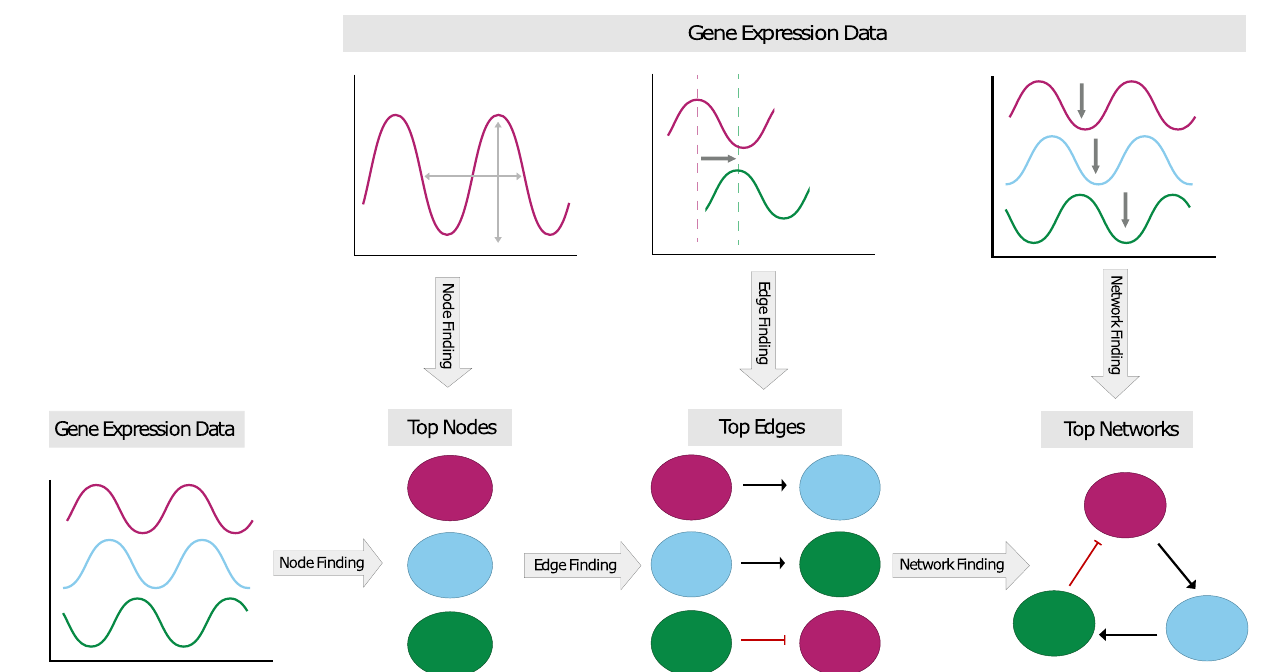
Fig 1. Schematic of the three stages of the Inherent dynamics pipeline in which each step uses different features of the input gene expression time series data. In the node finding step, each gene expression time trace is used independently to score the strength of periodicity. Genes with stronger periodicity and higher amplitude are hypothesized to be part of the core network and are correspondingly ranked higher. Top ranked nodes are passed into the edge finding step, where time series are used in pairs to score the likelihood of a positive or negative regulatory event in one or the other direction. A ranking is determined using high to low likelihoods and top ranked edges are passed to the network finding step, where subsets of gene expression data consisting of three or more time traces are compared to the global dynamics of network models to produce top ranking networks that are consistent with the order of peaks and troughs across the time series. Statistics of these top ranked networks are used to suggest experimental intervention at the node level.